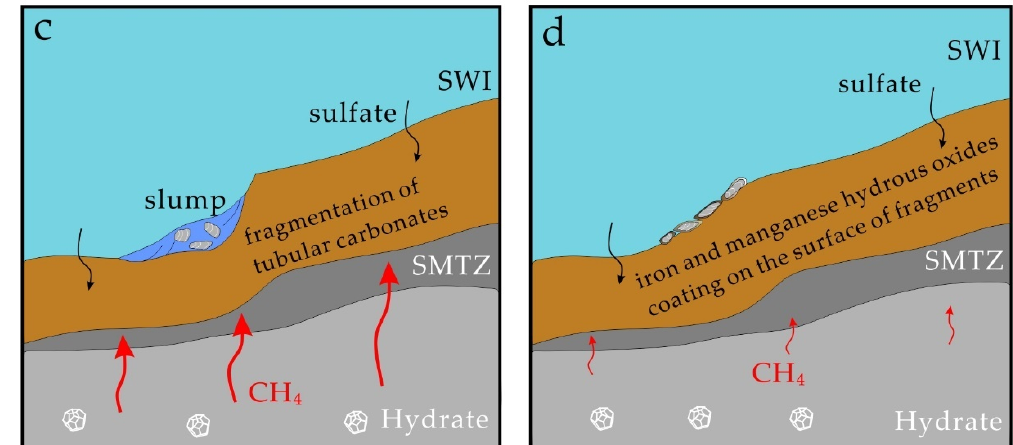
Figure 7. A conceptual model for the formation of the tubular carbonates from the northern South China Sea (not to scale). ( a ) Active methane seepage occurred in the passive margin setting. Burrows produced by megafauna served as conduits for methane and sulfate flow. ( b ) The upward movement of the SMTZ placed burrows into the zone of anaerobic oxidation of methane (AOM), which resulted in the lithification of the surrounding sediments and carbonate cement precipitation within the inner parts of the conduits. ( c ) Turbidity currents and sediment slumps and slides caused the fragmentation of tubular carbonates. The overlying sediments were then eroded by the strong bottom currents. ( d ) Iron and manganese hydrous oxides coated the surface of carbonates during prolonged exposure of pipe fragments to oxic seawater (Figure 7d). SWI = sediment water interface, SMTZ = sulfate methane transition zone.